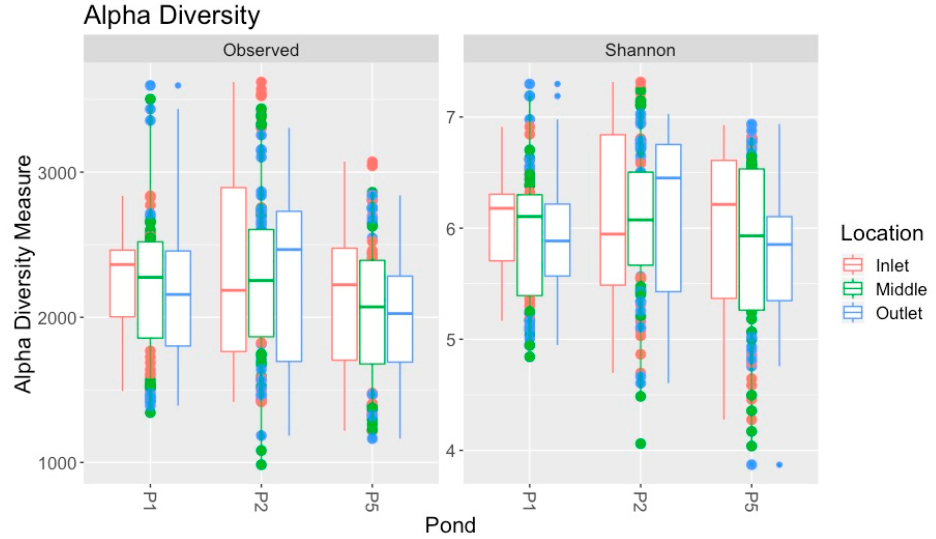
Figure A2. Alpha diversity (Observed and Shannon) for samples by pond number (x-axis) and location (red = Inlet, green = Middle and blue = Outlet) P1 = Pond 1, P2 = Pond 2 and P5 = Pond 5. Table A1. PERMANOVA analysis testing the di ff erences in bacterial Phyla between year (2012, 2013), season (early wet and dry), pond number (P1, P2 and P5), location within the ponds (inlet, middle and outlet), time of day (6 am and 1 pm) and depth of the water sampled (surface and benthic). The term “df” indicates degrees of freedom, “ECV” square root of estimates of components of variation indicating the e ff ect size as average% SV dissimilarity due to that factor (residual ECV 32.7). P value is based on > 9978 unique permutations; “PermDISP” permutational distance-based test for homogeneity of multivariate dispersions for main factors. *** P value = 0.001; ** P value < 0.01; * P value < 0.05.